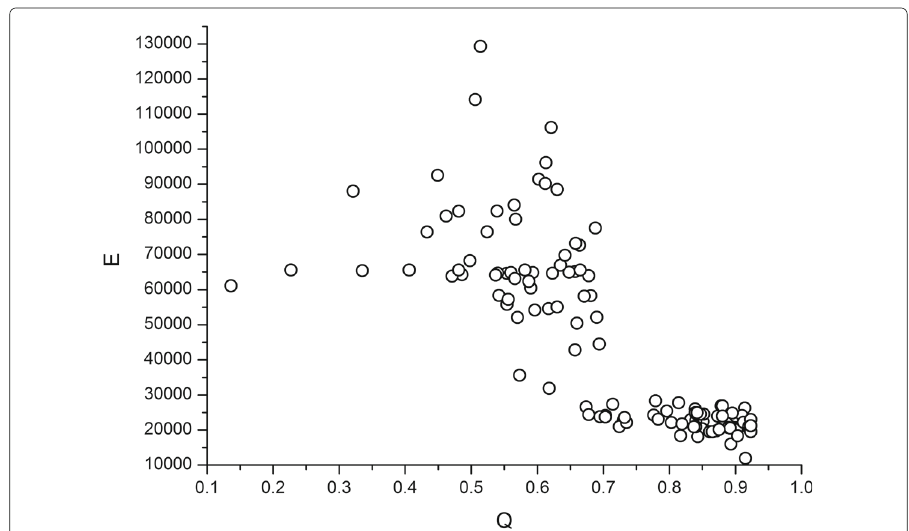
Fig. 5 Dispersion of the modularity (Q) as a function of the number of edges (E) of their respective visibility networks. Source: Author